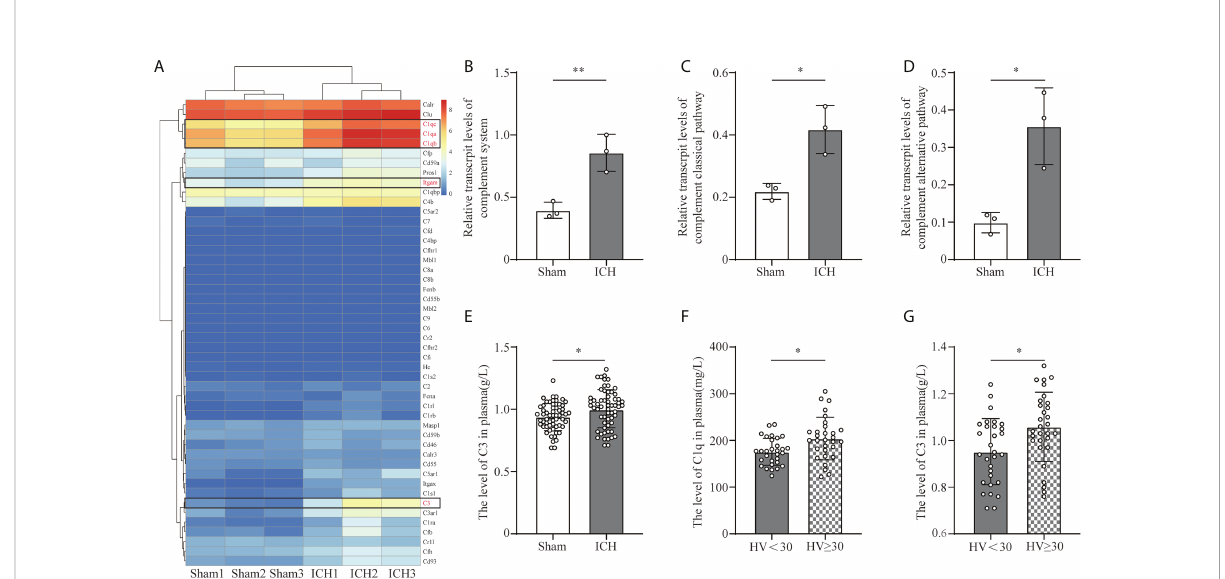
FIGURE 1 Complement activation after ICH. (A) Heat map of complement genes in mouse peri-hematomal brain tissue 3 days after ICH compared with the levels in the sham group. C1qa, C1qb, C1qc (C1q gene), C3 (C3 gene), and Itgam (CR3 gene) were signi fi cantly upregulated. n = 3. (B) Quantitative analysis of the complement system in transcriptive level in the hematoma edge after ICH. n = 3. **P <0.01 by two-tail Student ’ s t-test. (C) Quantitative analysis of the complement classic pathway at the transcriptive level in hematoma edge after ICH. n = 3. *P <0.05 by two-tail Student ’ s t-test. (D) Quantitative analysis of the complement alternative pathway in transcriptive level in the hematoma edge after ICH. n = 3. *P <0.05 by two-tail Student ’ s t-test. (E) Quanti fi cation of serum C3 in healthy people and ICH patients. n = 60. *P <0.05 by Welch ’ s t- test. (F) Quanti fi cation of C1q in plasm in patients with hematoma volume <30 ml and hematoma volume ≥ 30 ml. n = 30. *P <0.05 by Welch ’ s t-test. (G) Quanti fi cation of C3 in plasm in patients with hematoma volume <30 ml and hematoma volume ≥ 30 ml. n = 30. *P <0.05 by two-tail Student ’ s t-test. Data are represented as mean ±